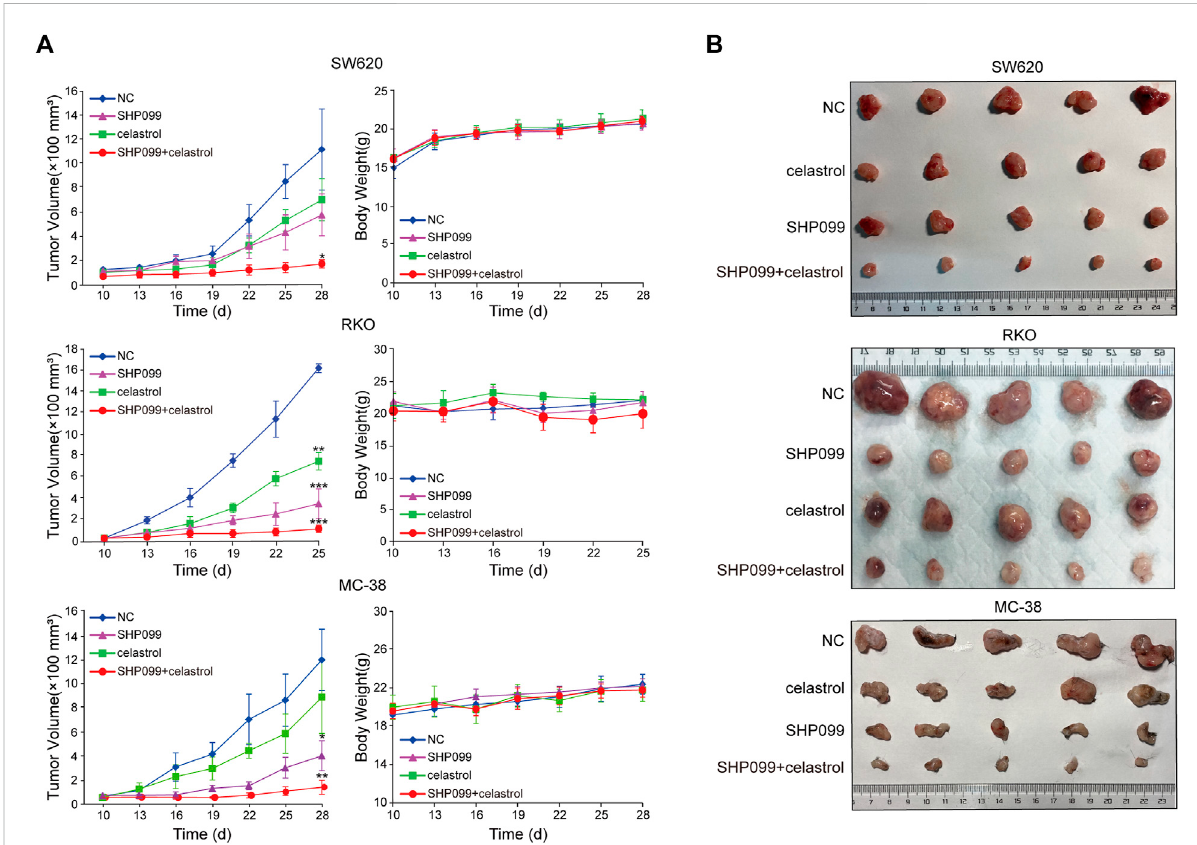
FIGURE 5 S HP099 cooperates with celastrol to suppress tumor growth in xenograft animal models. (A) Tumor volume and body weight variations after the treatment of celastrol alone, SHP099 alone, or their combination in animal models; (B) . representative images of tumors treated with celastrol alone, SHP099 alone, or their combination. * p < 0.05; ** p < 0.01; *** p <